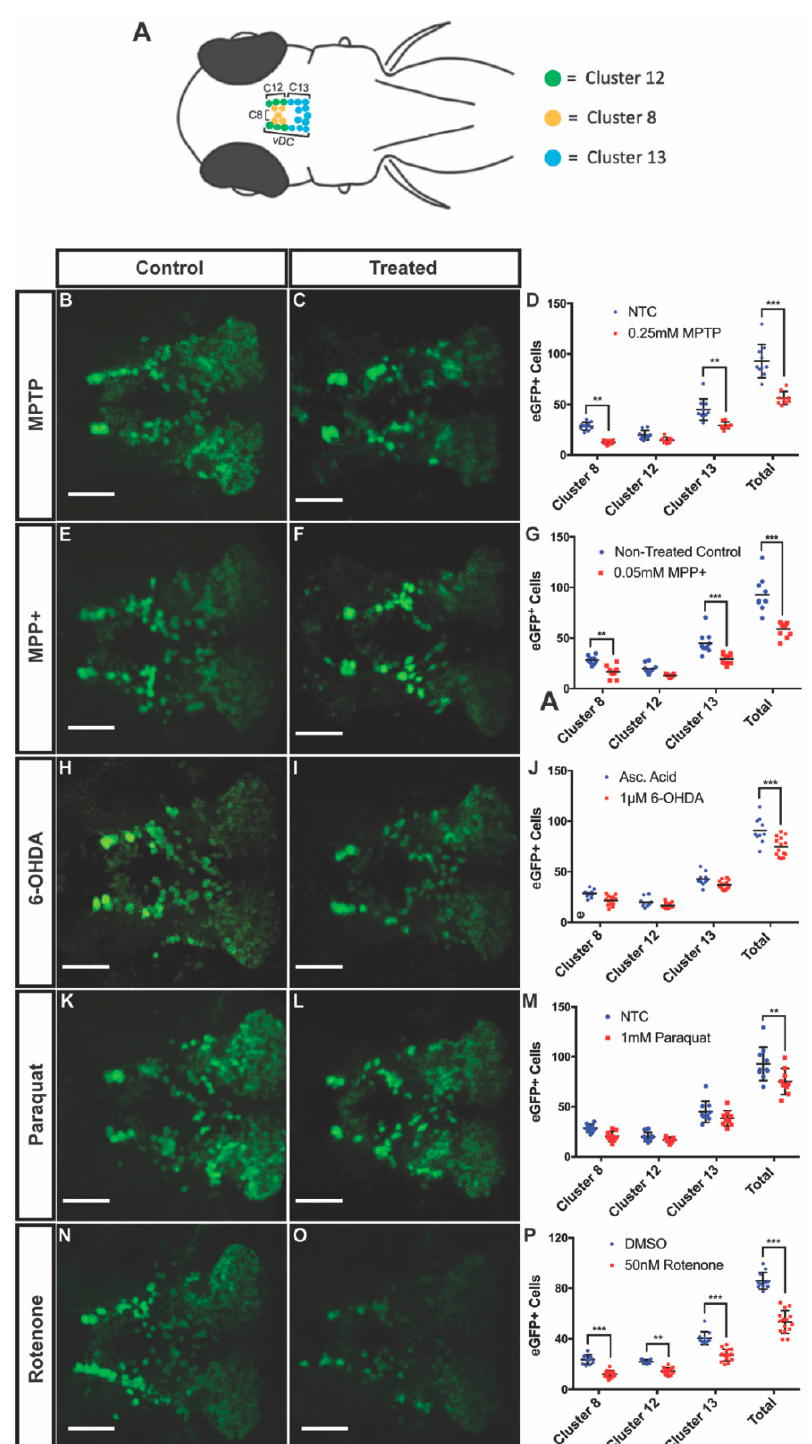
Figure 3. Effects of neurotoxins on ventral diencephalic (vDC) DAnergic clusters of 7 dpf Tg( dat:eGFP ) zebrafish. ( A ) Schematic representation of eGFP neuronal clusters 8, 12, and 13 within the vDC. Cluster 8 in yellow, cluster 12 in green, and cluster 13 in blue. Dorsal view with anterior to the left. ( B – P ) Quantification eGFP + cells within the vDC through confocal fluorescent live imaging following exposure to 0.25 mM MPTP, 0.05 mM MPP + , 1 uM 6-OHDA, 1 mM paraquat, and 50 nM rotenone ( n = 9–15). All images were acquired using a maximum projection of 2µm z-stacks, scale bar = 100µm. Bars represent the Mean ± the SEM. * ( p < 0.05), ** ( p < 0.01), *** ( p < 0.001).